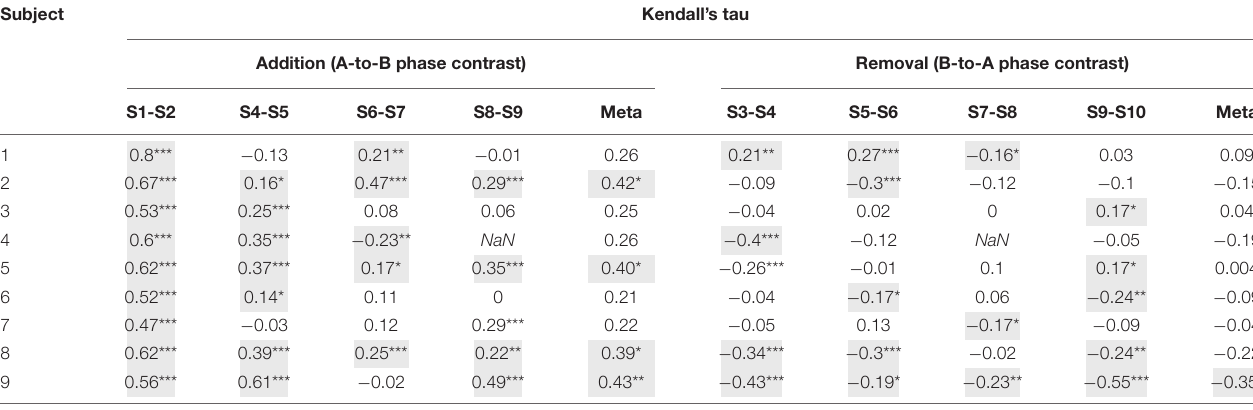
TABLE 2 | Kendall’s tau non-overlap indices for consecutive